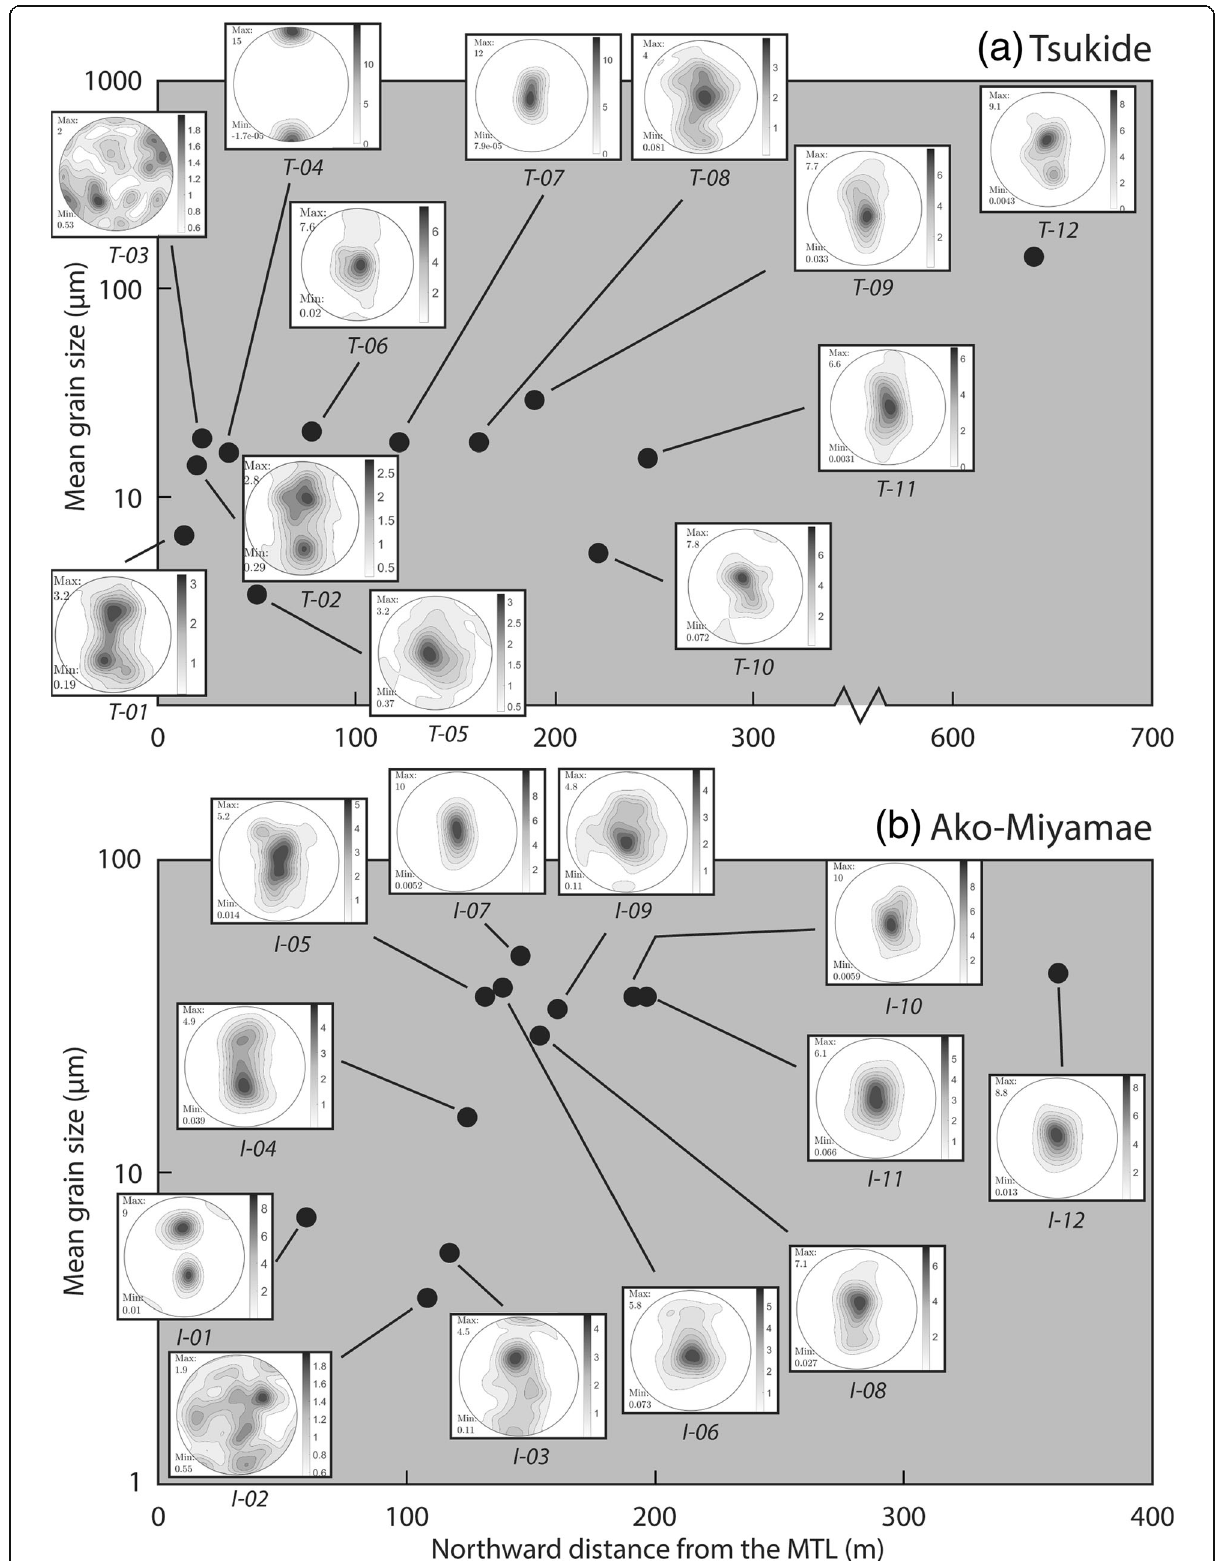
Fig. 9 Variation in quartz recrystalised grain size and [ c ]-axis fabric with distance from the MTL in the Tsukide ( a ) and Ako – Miyamae ( b )